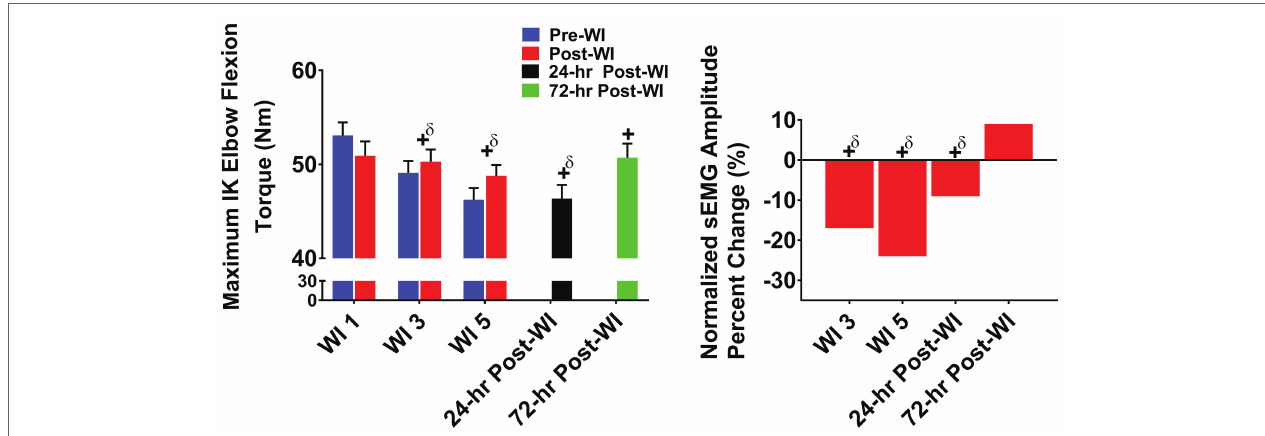
FIGURE 6 | Maximum IK elbow flexion results. Across subject ( n = 13) mean ± SEM is shown. Left graph – performance (torque): no group differences were present. Performance declined throughout the dive week and did not recover by 72-h post-WI. “+” denotes time main effect ( p < 0.05). Main effect symbol with “ δ ” denotes ( p < 0.001). Right graph – normalized sEMG day percent change: biceps brachii neuromuscular activation declined throughout the dive week and into 24-h post-WI when compared to WI 1. “+” denotes time main effect ( p < 0.05). Main effect symbol with “ δ ” denotes ( p <